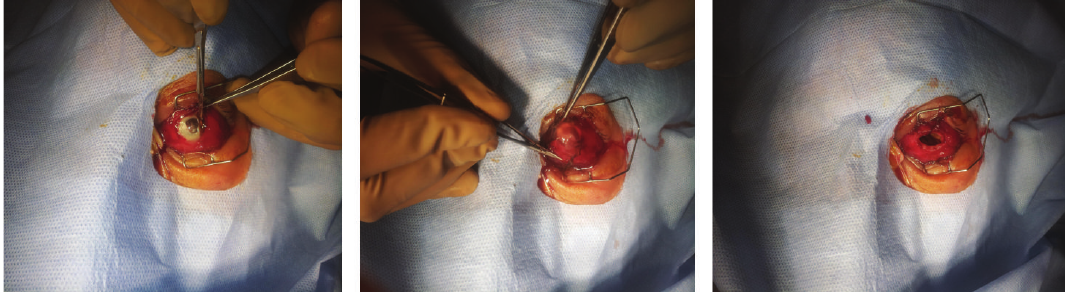
Figure 3: Intraoperative findings showed melting cornea and the left eye was